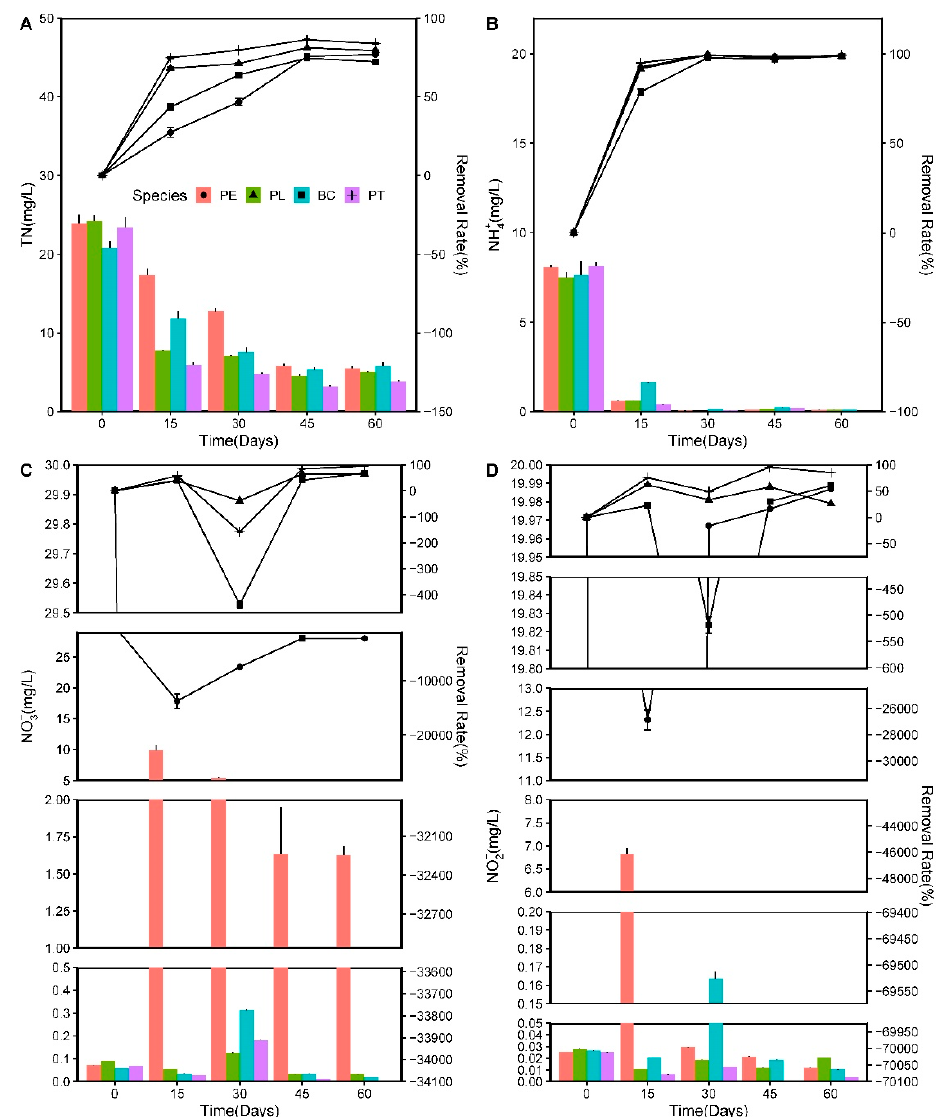
Figure 6. Variations in N concentration and homologous removal rate in the experiment: ( A ) concentration and removal rate of TN; ( B ) concentration and removal rate of NH 4 + ; ( C ) concentration and removal rate of NO 3 − ; and ( D ) concentration and removal rate of NO 2 − .